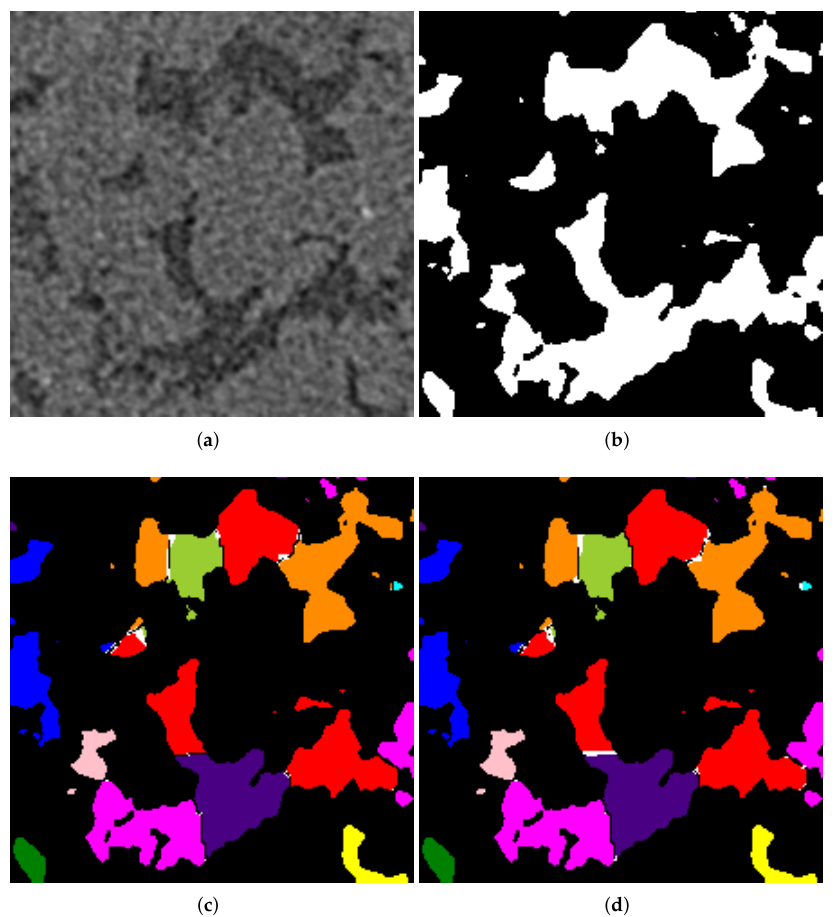
Figure 18. Fragment of ( a ) slice of the micro-CT image; ( b ) segmented pore space; results of segmen- tation via ( c ) IPSDK and ( d ) Avizo: pore bodies (different colors), difference between repeatable and fast versions